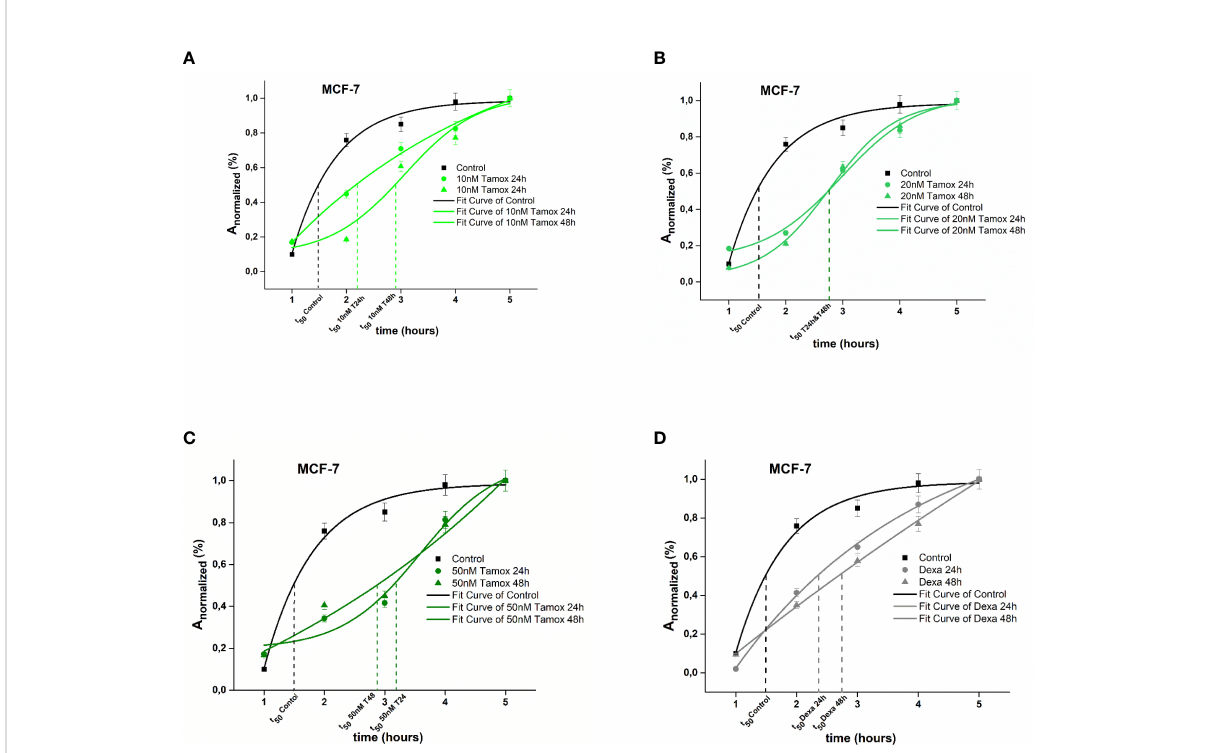
FIGURE 2 Plotted normalized cell area interprets spreading kinetics. Merged experimental curves of three repeated tests of the spreading rate ( dA normalized / dt ) of Control vs 10 nM tamoxifen (A) , Control vs 20 nM tamoxifen (B) , Control vs 50 nM tamoxifen MCF-7 (C) and Control vs dexamethasone (D) are